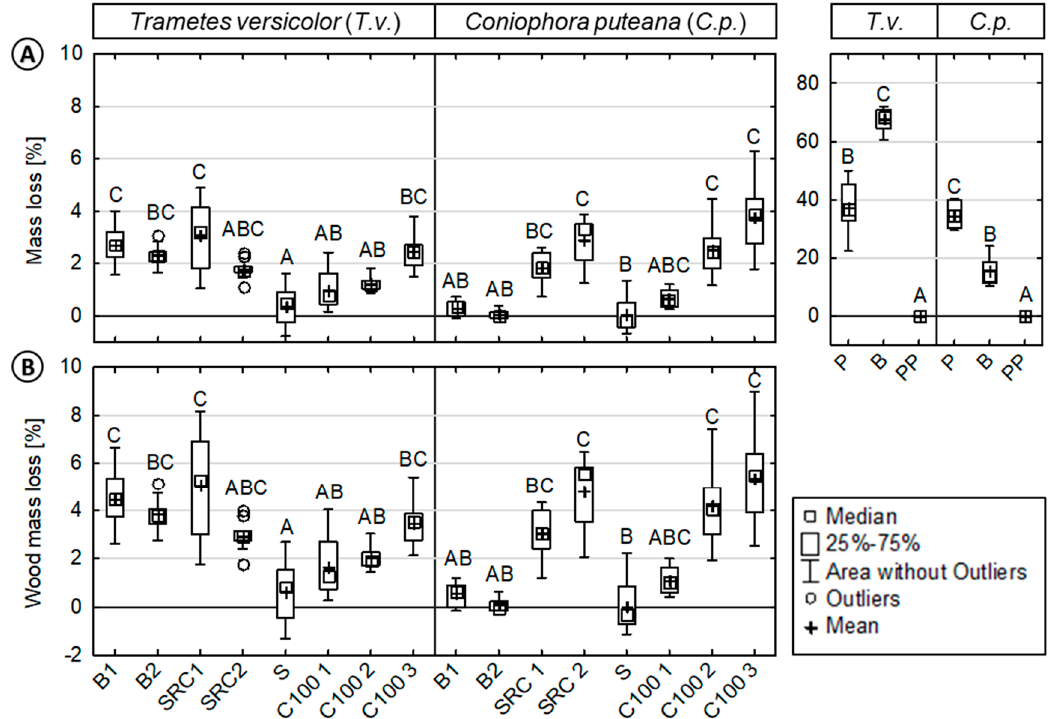
Figure 1. Resistance of injection molded wood-polypropylene composites and reference materials against basidiomycetes. (Left): ( A ) Mass loss (ML) and ( B ) wood mass loss (WML) of the composites / reference materials inoculated with Trametes versicolor ( T.v. ) or Coniophora puteana ( C.p. ). (Right): ML of the reference materials (beech wood, pine sapwood, and polypropylene). Results of the statistical analyses are displayed, where values assigned with the same letter are not significantly di ff erent from each other at a significance level of α = 0.05 (Kruskal-Wallis). The mass loss evaluation of the virulence control samples showed that the test was valid (average mass loss > 20%). Pinus sylvestris virulence control samples showed an average weight loss of 41.4% ( ± 7.2) and Fagus sylvatica virulence control samples of 28.3% ( ± 1.9) (data not shown),